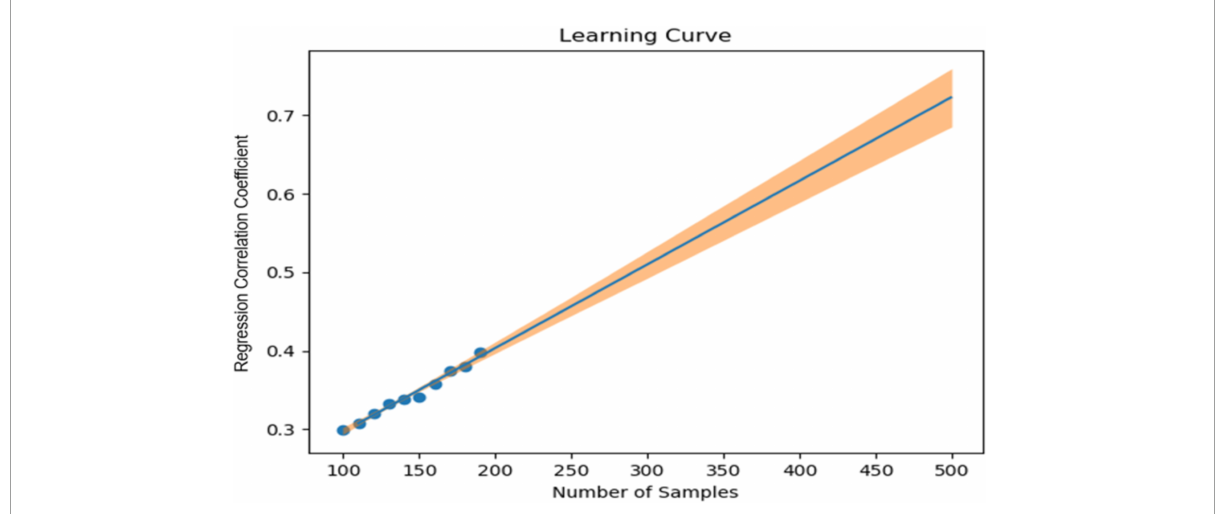
FIGURE2 Sample size (X-axis) and correlation coefficient for the 17-item version of the Hamilton Depression Rating Scale (HAMD) measured values and the estimated values (Y-axis).